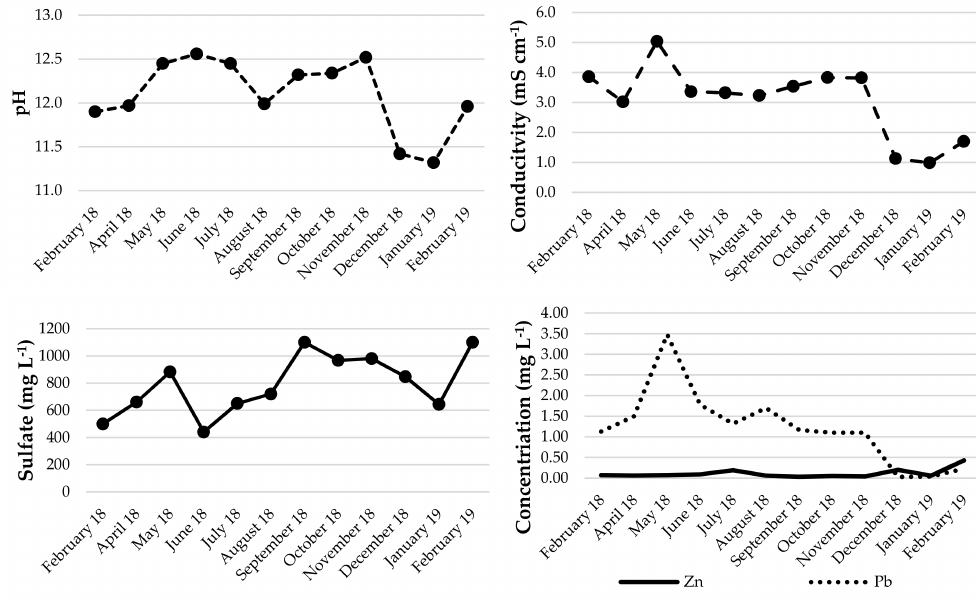
Figure 5. Evolution of selected parameters in flotation wastewater.